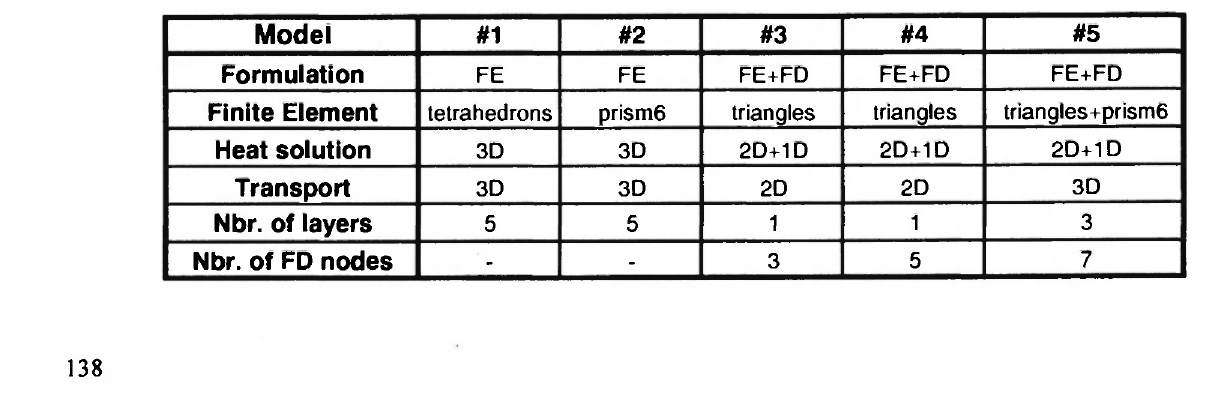
Description of the five models used to compute the non-isothermal filling and curing of the automotive front